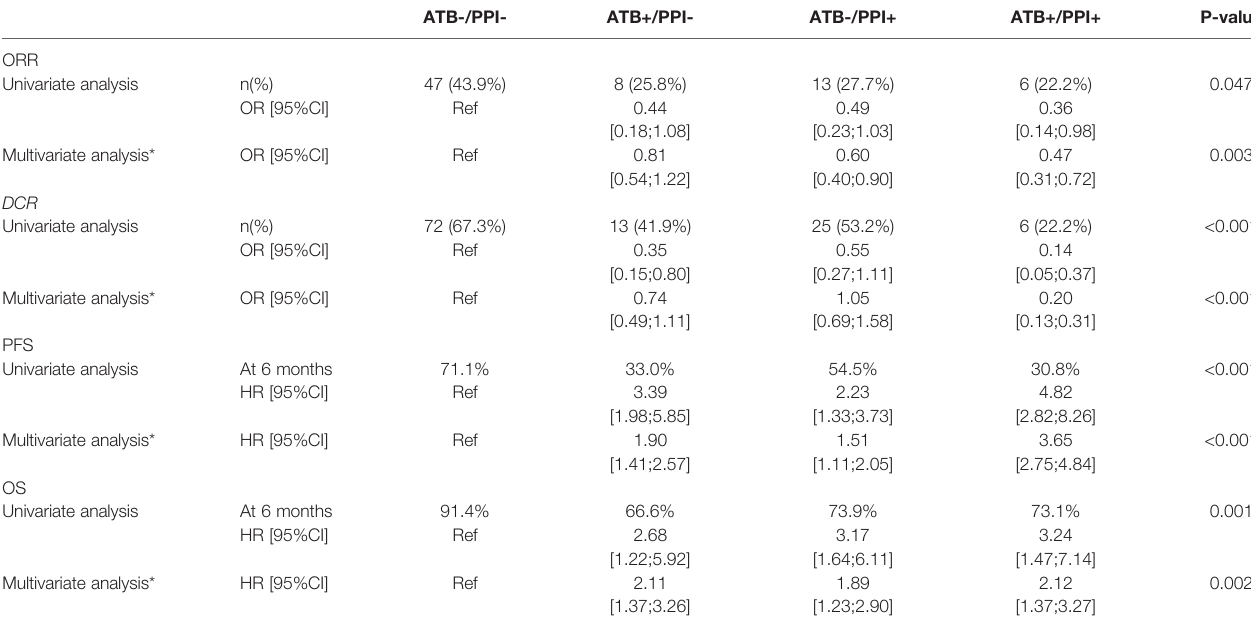
TABLE 4 | Patient outcomes according to ATB and/or PPI use.